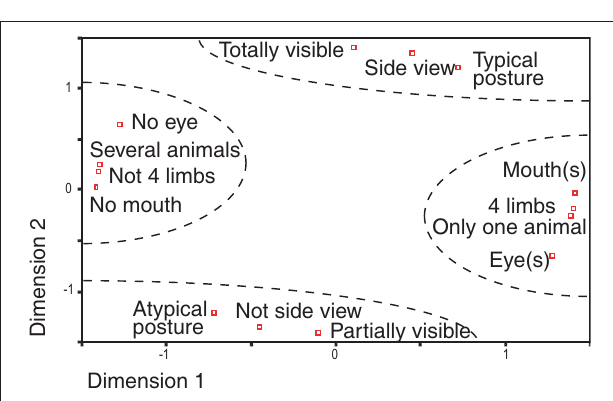
Figure 5 | influences of diagnostic animal features on performance. (A) Presence of eyes. (B) Presence of a mouth (muzzle or beak according to the type of animal). (C) presence of four limbs in the photograph (only considers animals with legs). On the top row, reaction time distributions are represented (20-ms time bins). On the bottom row, the accuracy cumulated across time is